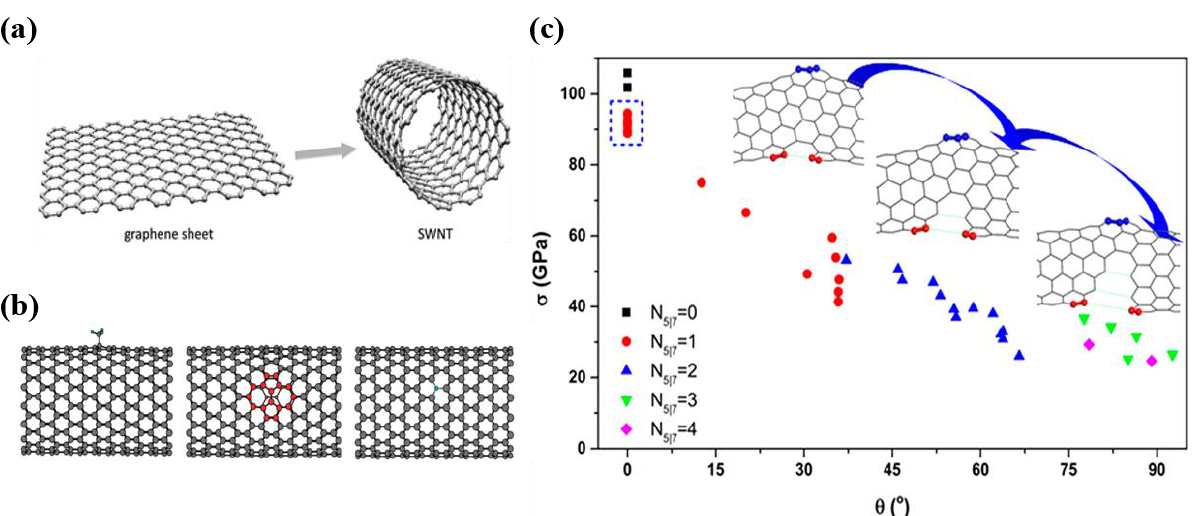
Figure 2. ( a ) Wrapping of graphene sheet to form an SWCNT. Reproduced with permission from [25]. Copyright 2011, Royal Soc Chemistry. ( b ) Defects on the SWCNT, from left to right: functionalization defect, SW defect, and vacancy, respectively. Reproduced with permission from [14]. Copyright 2007, Iop Publishing Ltd. ( c ) The tensile strength of carbon nanotube varies with different numbers of 5|7 defects and different chiral angles. Reproduced with permission from [12]. Copyright 2016, Amer Chemical